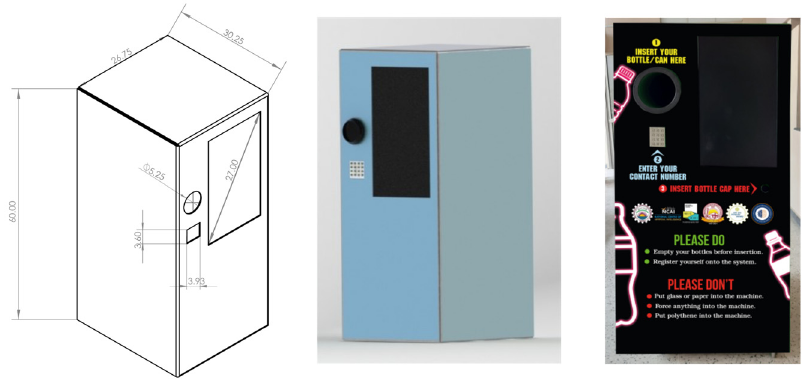
Figure 3. Computer-aided design of the proposed RVM (measurement unit: inches).